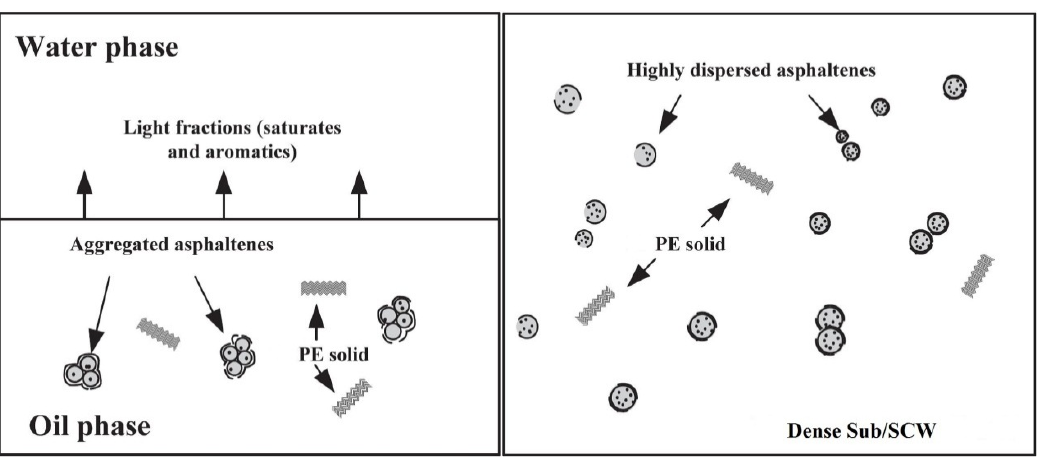
Figure 1. Initial phase structure of residual oil/PE/Sub or SCW; ( left ) liquid/liquid/solid three-phase structure; ( right ) liquid/solid two-phase structure. Reproduced with permission from [49], published by Elsevier Limited,